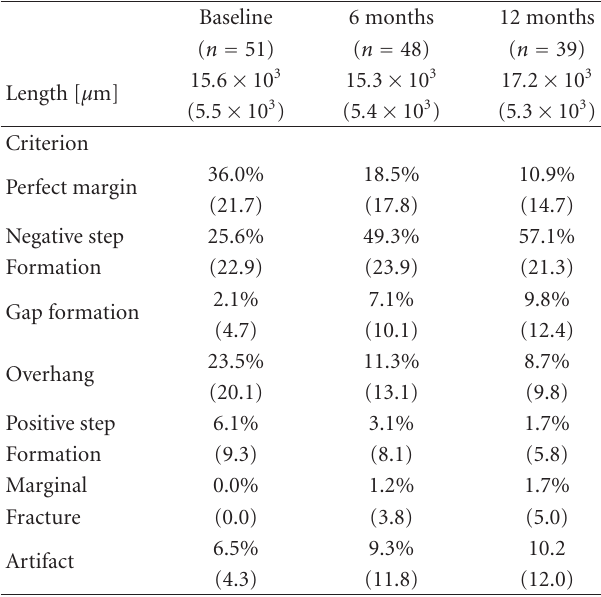
Table 2: SLM margin analysis of all